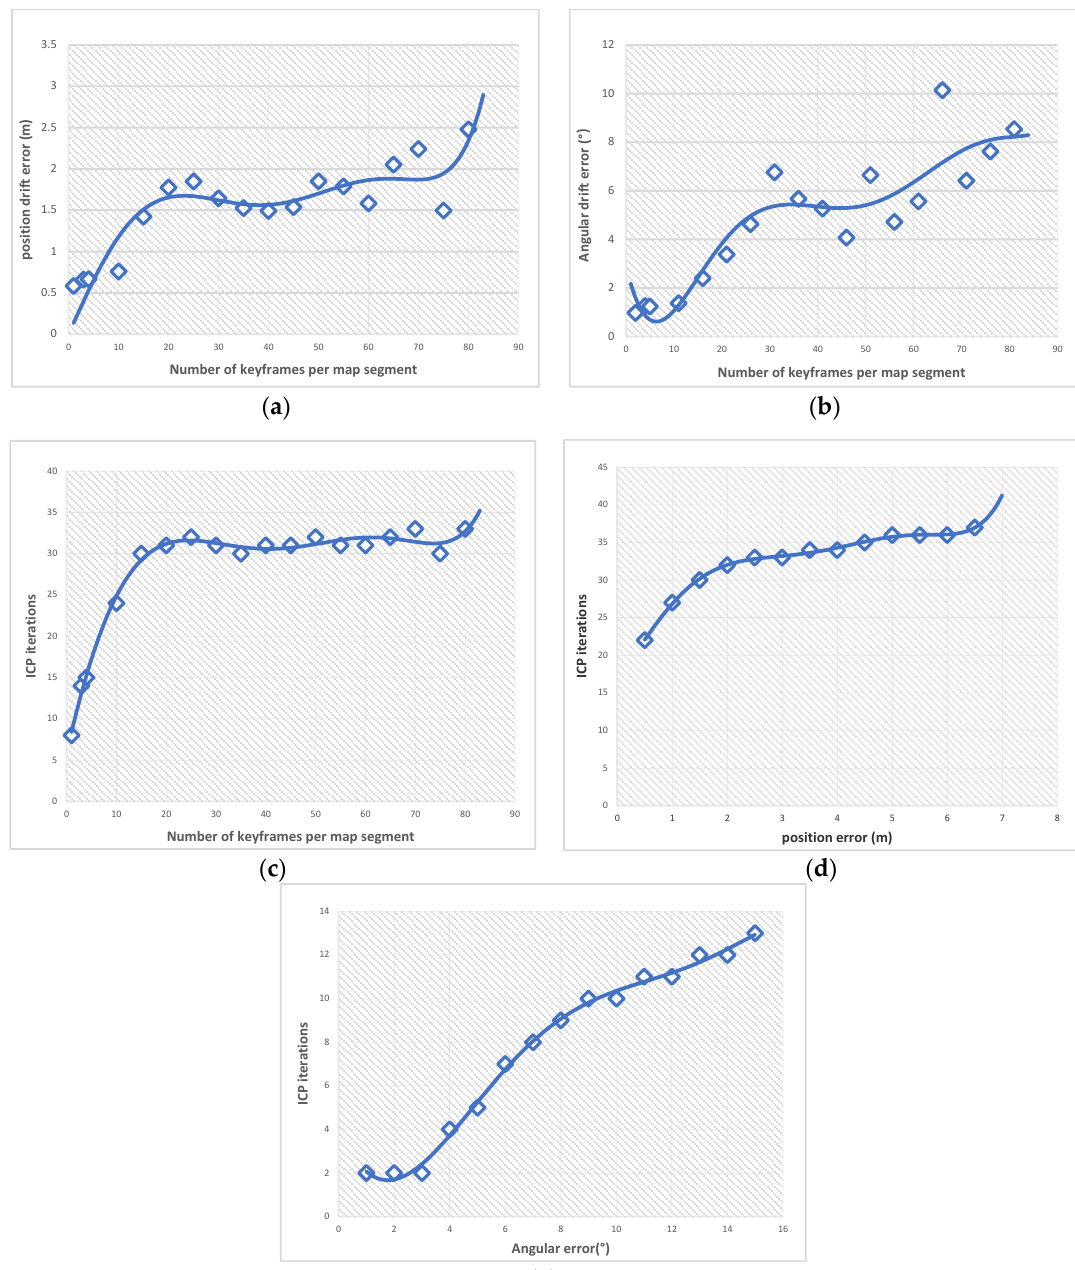
Figure 20. Correlation between the number of keyframes per map segment and cumulative error as well as LiDAR data optimization time. ( a ) Correlation between position drift error and number of keyframes per map segment, ( b ) correlation between angular drift error and number of keyframes per map segment, ( c ) correlation between ICP iterations and number of keyframes per map segment, and ( d ) correlation between ICP iterations and position error; ( e ) correlation between ICP iterations and angular error.